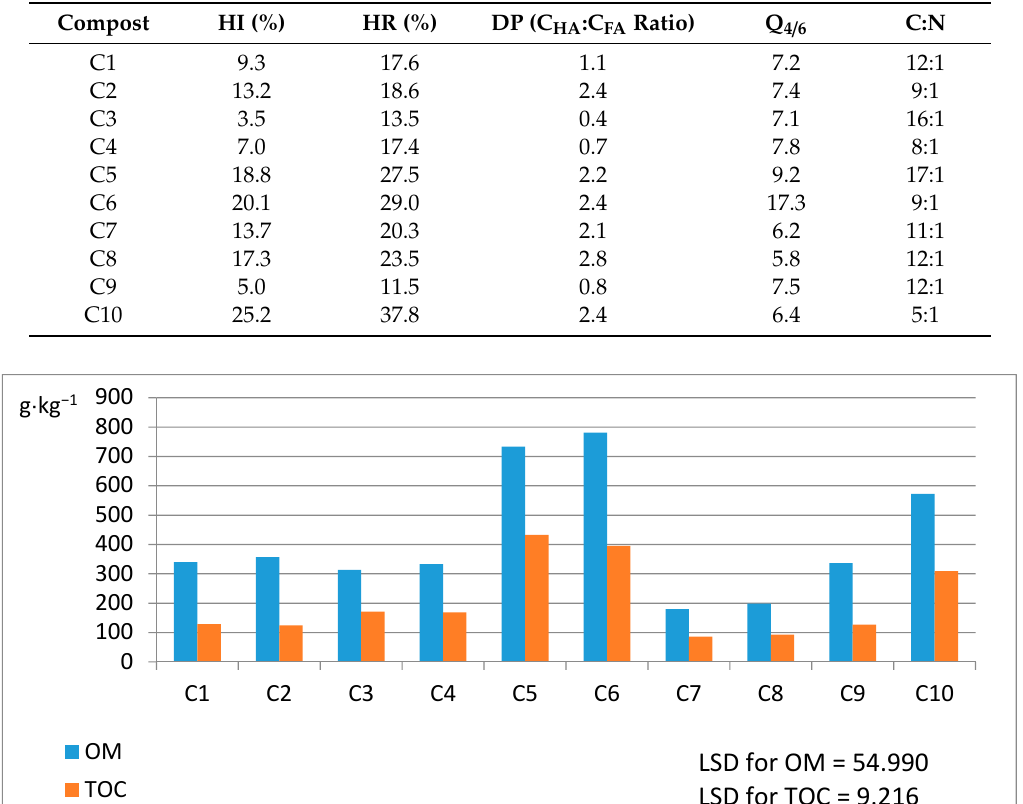
Table 2. The C:N ratio and humification indexes obtained for analysed composts. DP: degree of polymerisation, HI: humification index, HR: humification ratio.